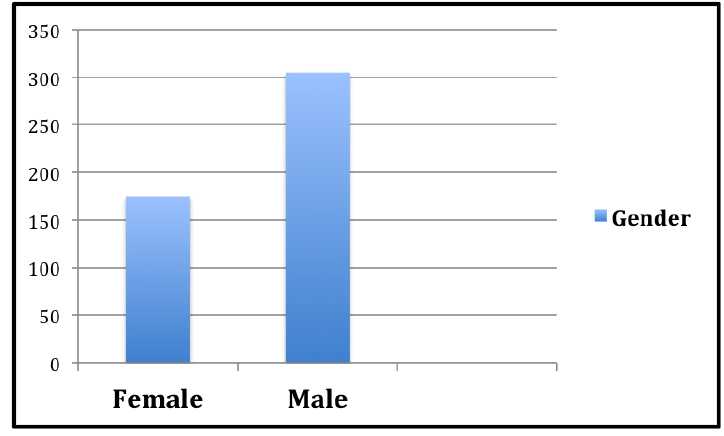
Figure 1. Student gender.